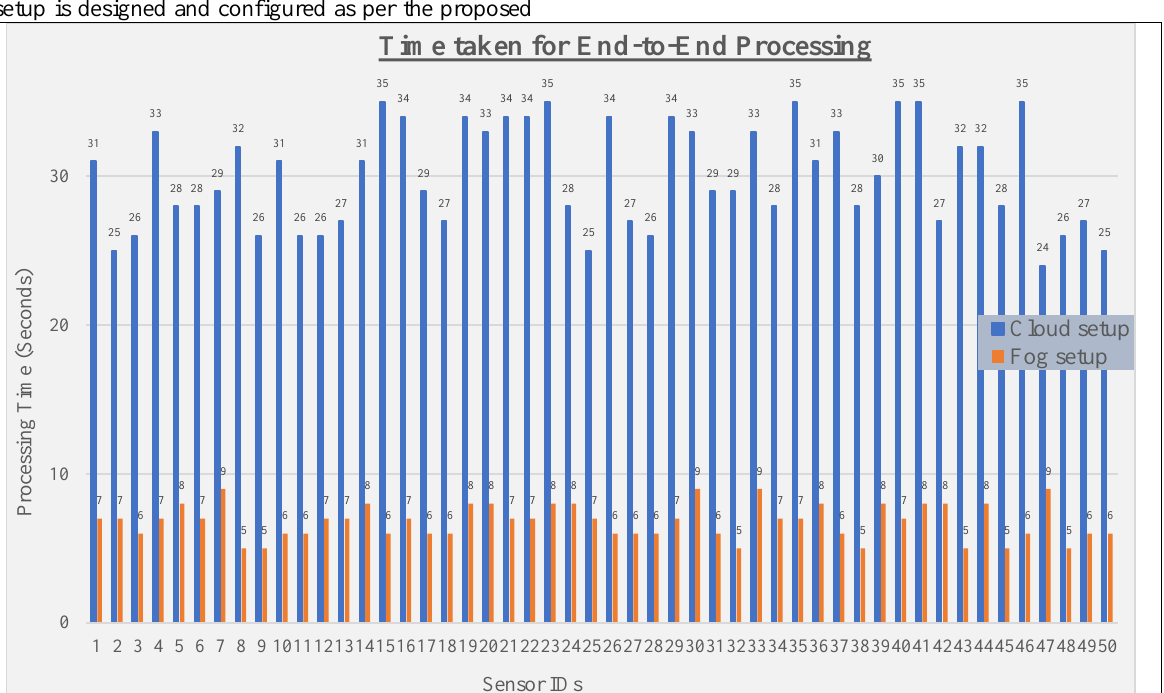
Figure 5. Fog and Cloud Execution Time